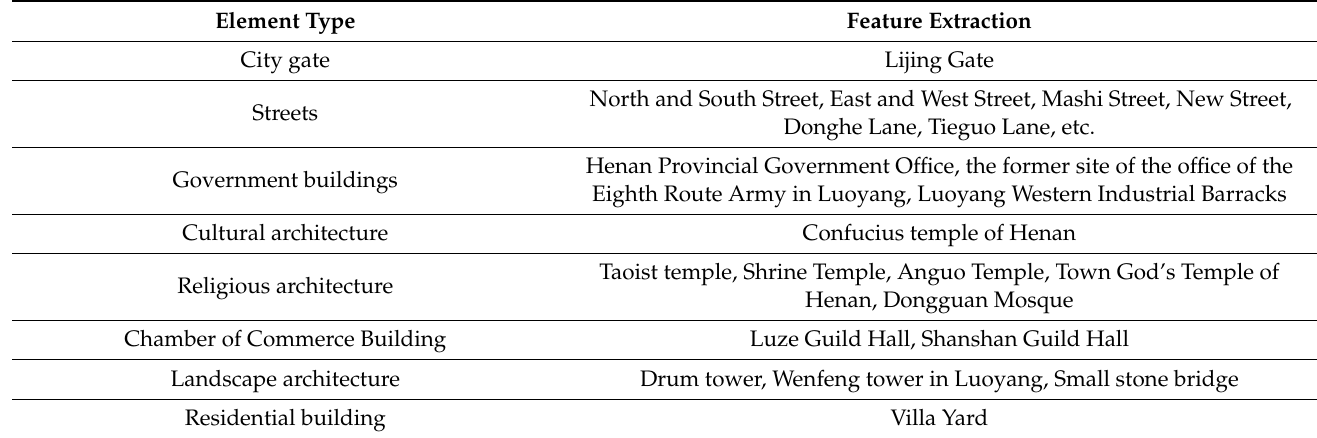
Table 3. Extraction of urban spatial elements in pre-modern